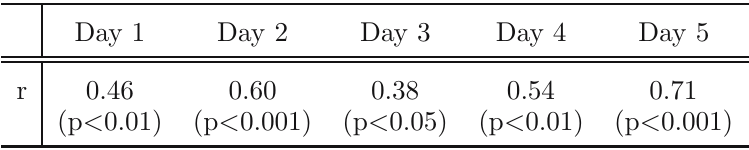
Fig. 2 The distribution of neutrophil direct count in AP patients on the 1 st and 3 rd day after hospital admission. Table 3 Monocyte-neutrophil correlations in AP patients. Spearman correlation coeffi- cient (r) and p level